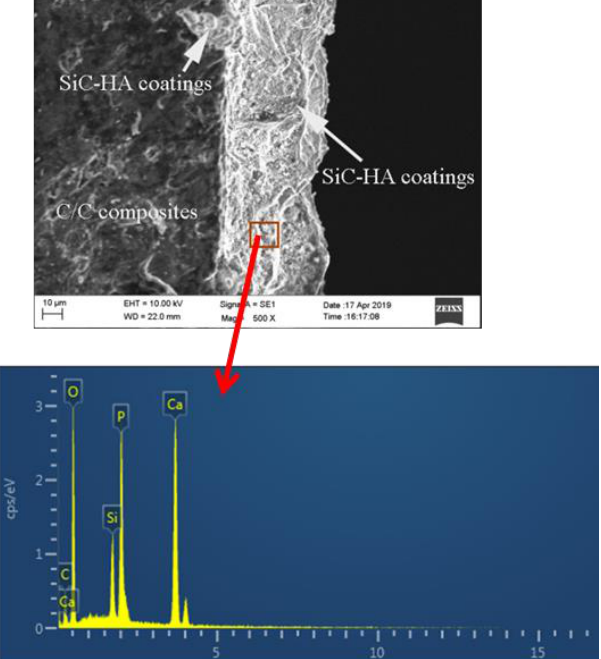
Figure 7. Surface morphology and EDS of SiC-hydroxyapatite coatings at different concentrations of SiC particles: ( a ) 0.01 g/L; ( b ) 0.1 g/L; ( c ) 1 g/L.